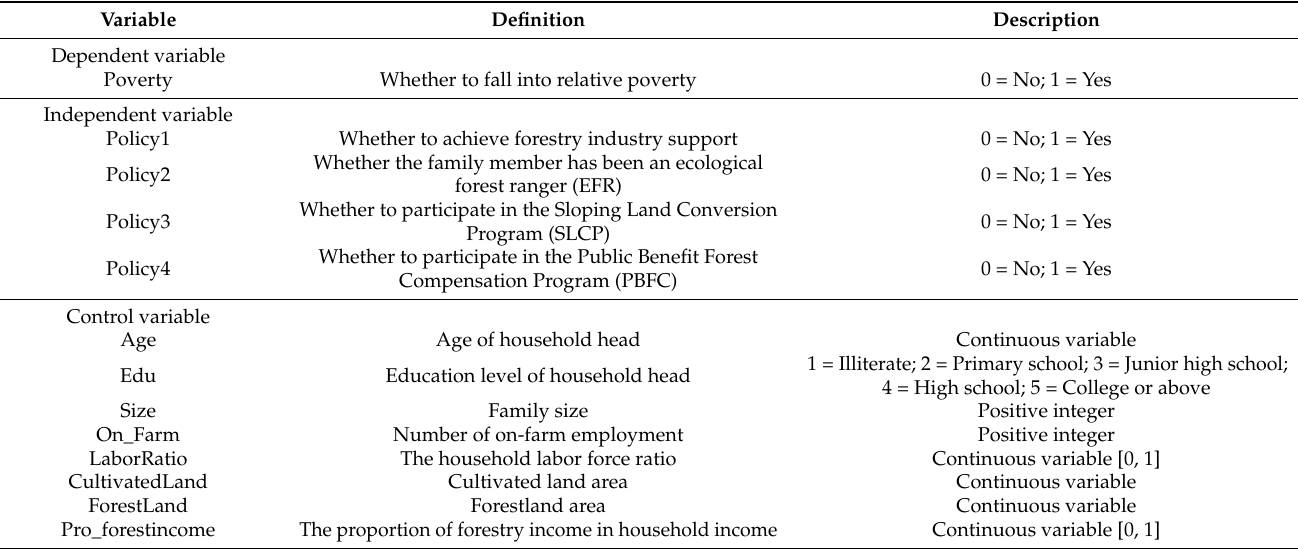
Table 3. The definition and description of